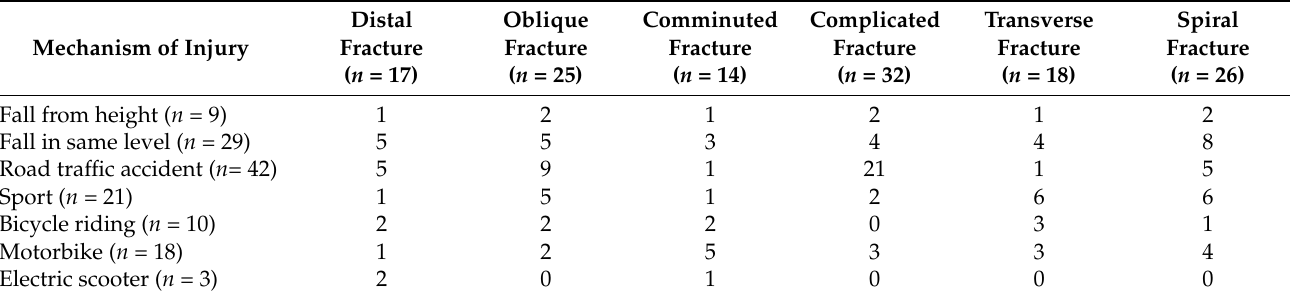
Table 2. Distribution of the patients according to fracture type and mechanism of